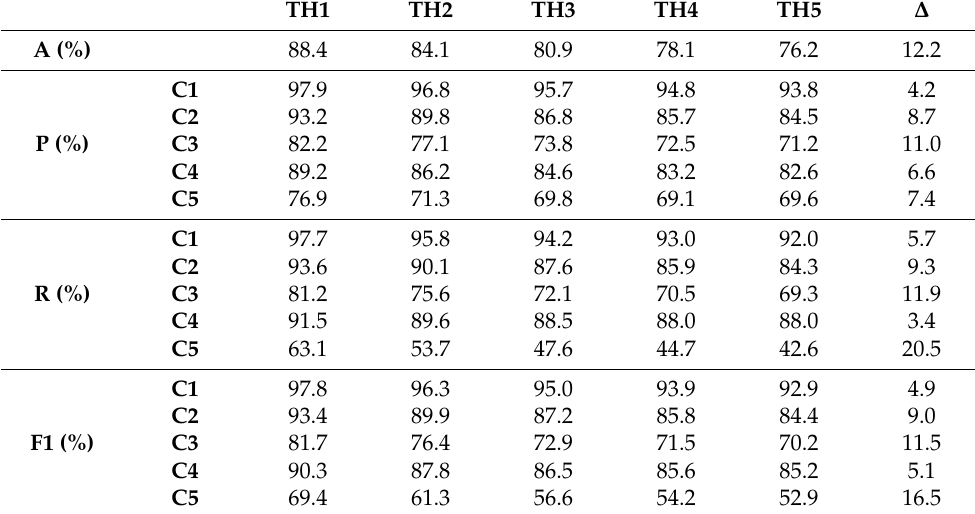
Table 6. Indexes of performance for RF